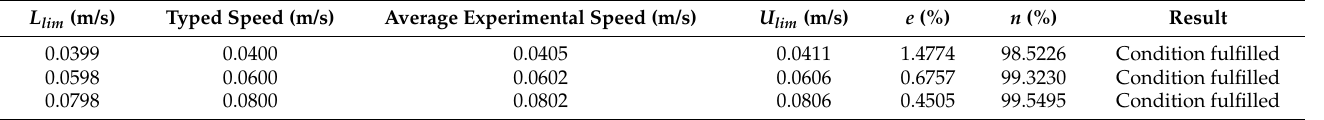
Table 1. Results of the error associated with the measurement of